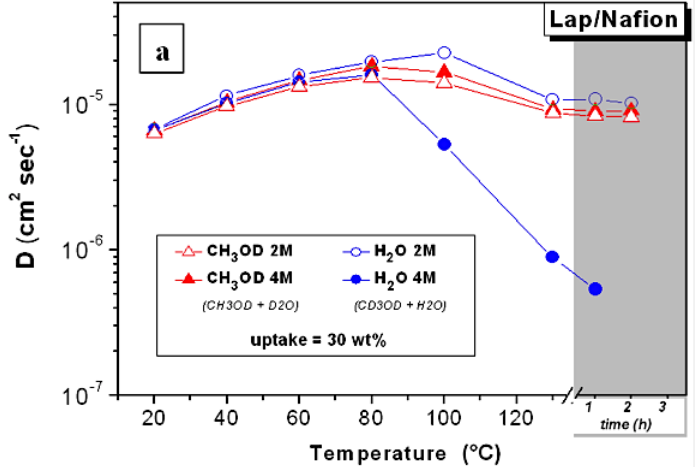
Figure 6. ( a ) Self-diffusion coefficients and ( b ) longitudinal relaxation times (T1) of